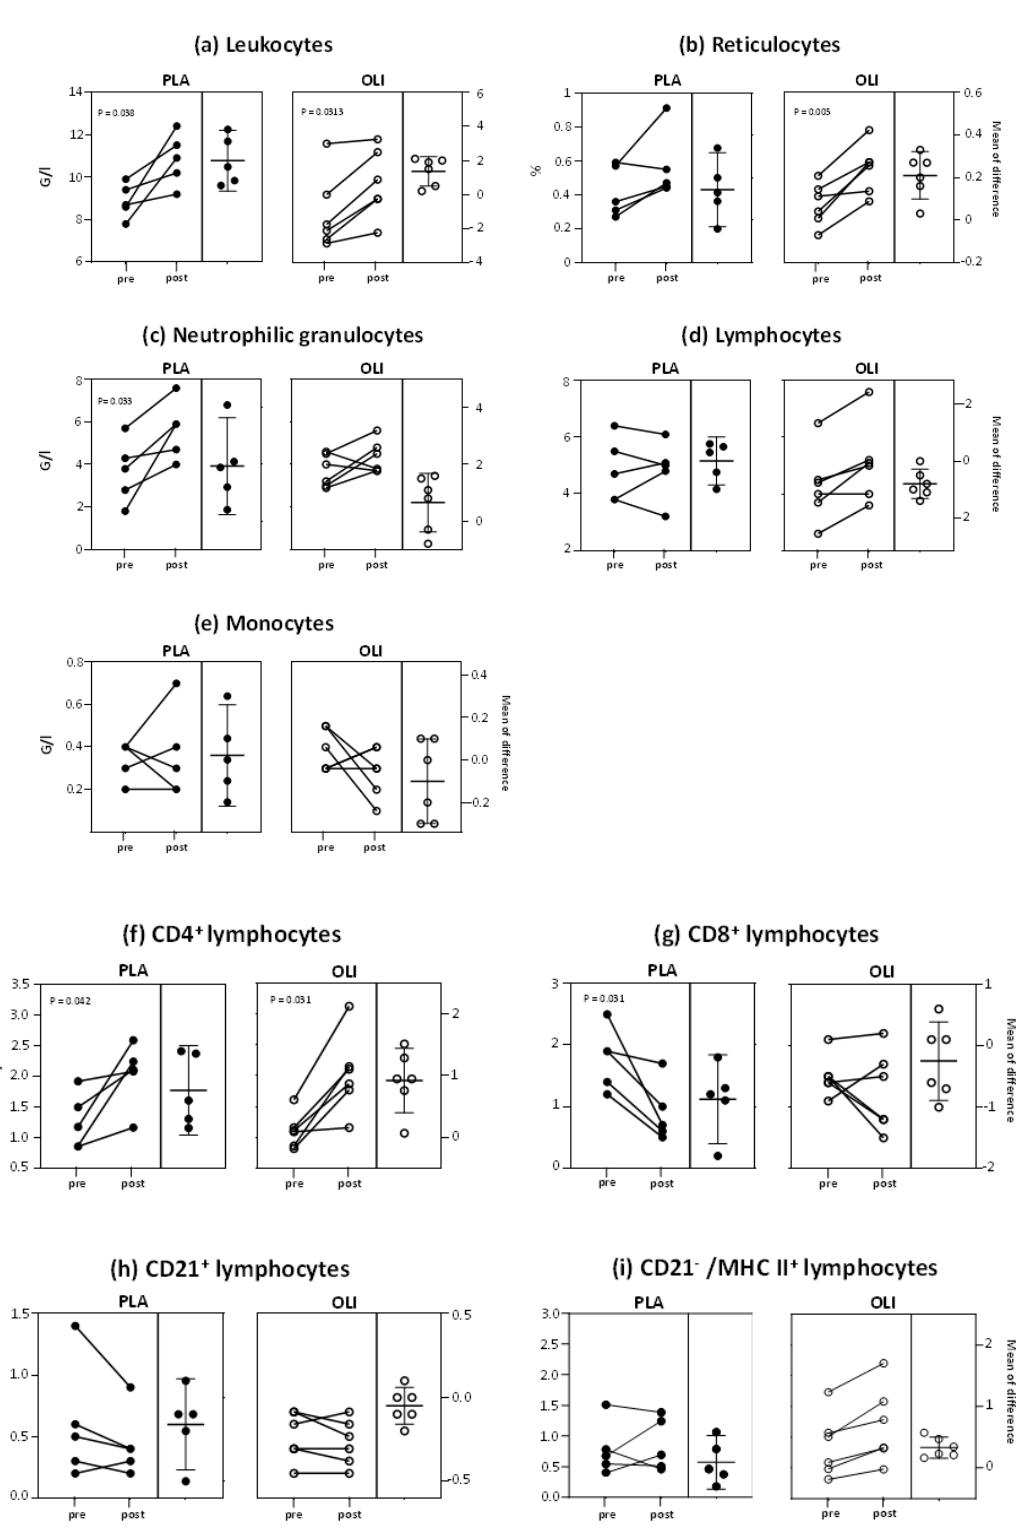
Figure 2. Vaccination-induced changes in leukocyte counts and reticulocyte proportions in blood. Cell counts and proportions of reticulocytes were determined by flow cytometry on the day of vaccination (pre) and 24 h after vaccination (post). Shown are individual responses and mean differences of vaccinated horses (OLI, n = 6; PLA, n = 5). p values were determined by paired t -test or signed-rank test and describe significances before and after vaccination within a